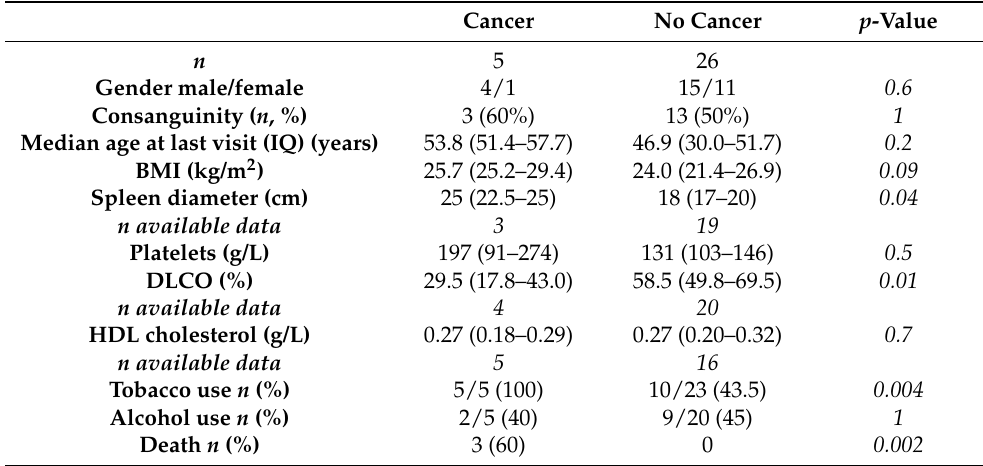
Table 2. Characteristics of patients with or without cancer (BMI: body mass index).